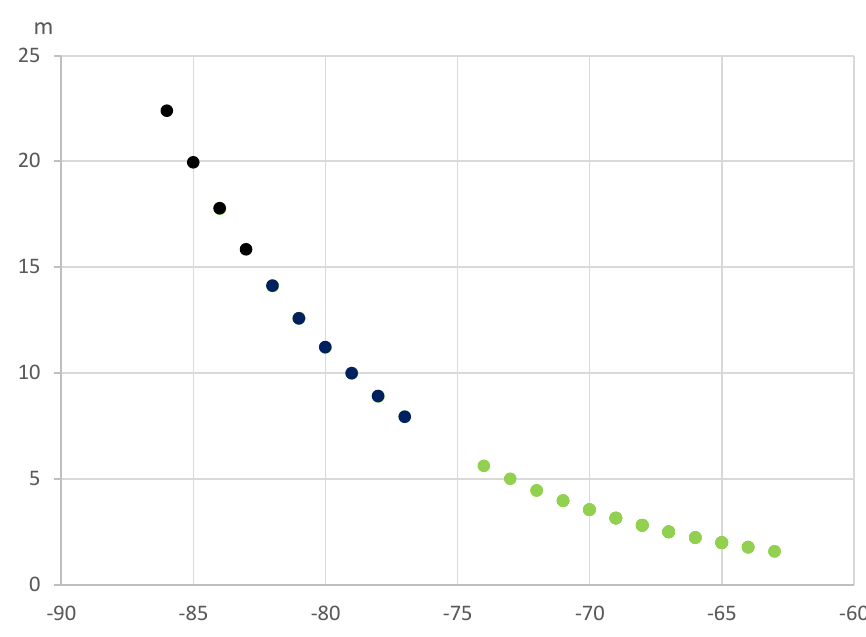
Figure 5. Two Bluetooth signal distribution groups after k mean clustering.